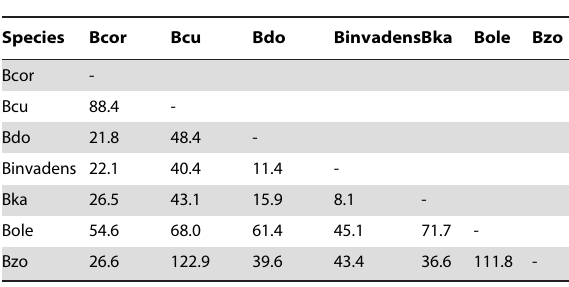
Table 3. Mahalanobis Squared Distances (D 2 ) between clusters representing the species/populations of